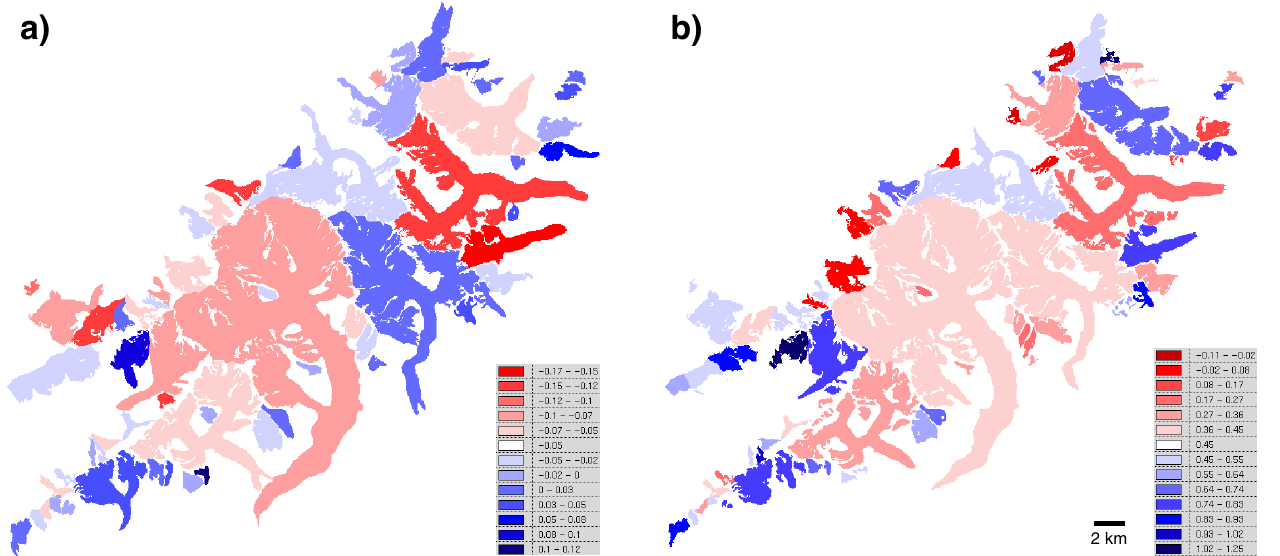
Fig. 4. (a) Change in mean mass balance due to a change of the DEM (difference 1). (b) Change in mean mass balance due to a change of glacier extent (difference